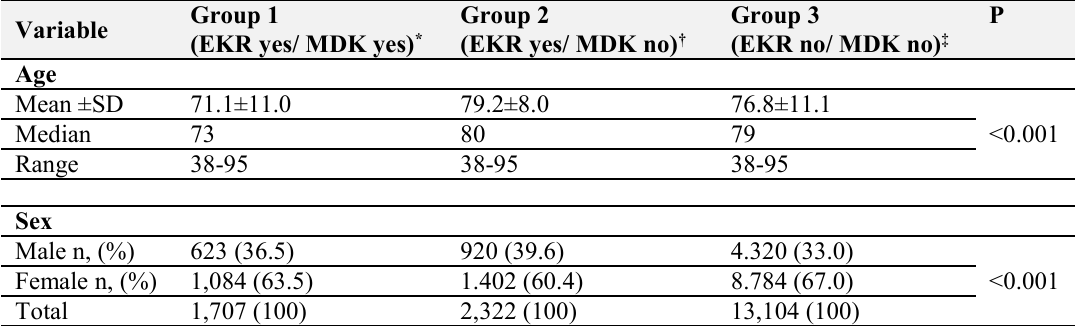
Table 1. Age and sex of MDK patients grouped by cancer case status in cancer registry (EKR) and MDK database (cancer cases in groups 1 and 2 restricted to colon, breast and